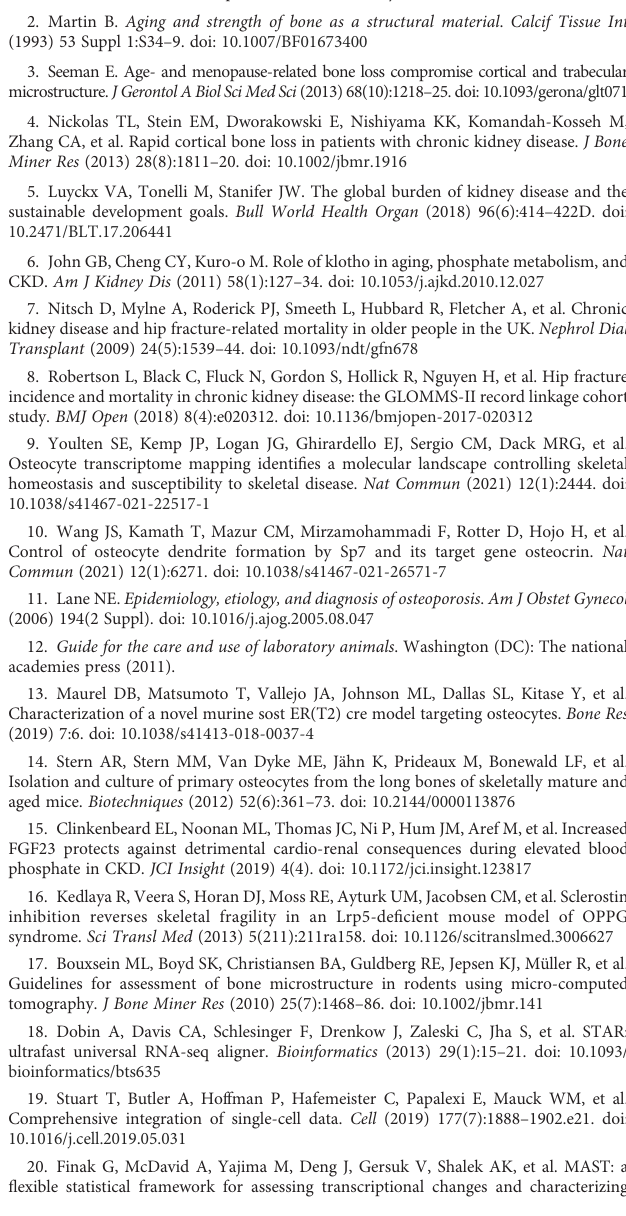
Osteocyte and osteoblast cell numbers in cortical and trabecular bone. (A) . The image shows osteocytes in the lacunae from femurs that were stained with hematoxylin and eosin. (B) . Osteocyte numbers from cortical bone were counted in the midshaft of bone and normalized to bone area. For counting of osteocytes in trabecular bone, cells were counted in distal femur excluding endocortical surfaces and primary spongiosa, then normalized to trabecular bone area. Osteoblasts were counted in distal femur in the same trabecular region as where osteocytes were counted and normalized to trabecular bone